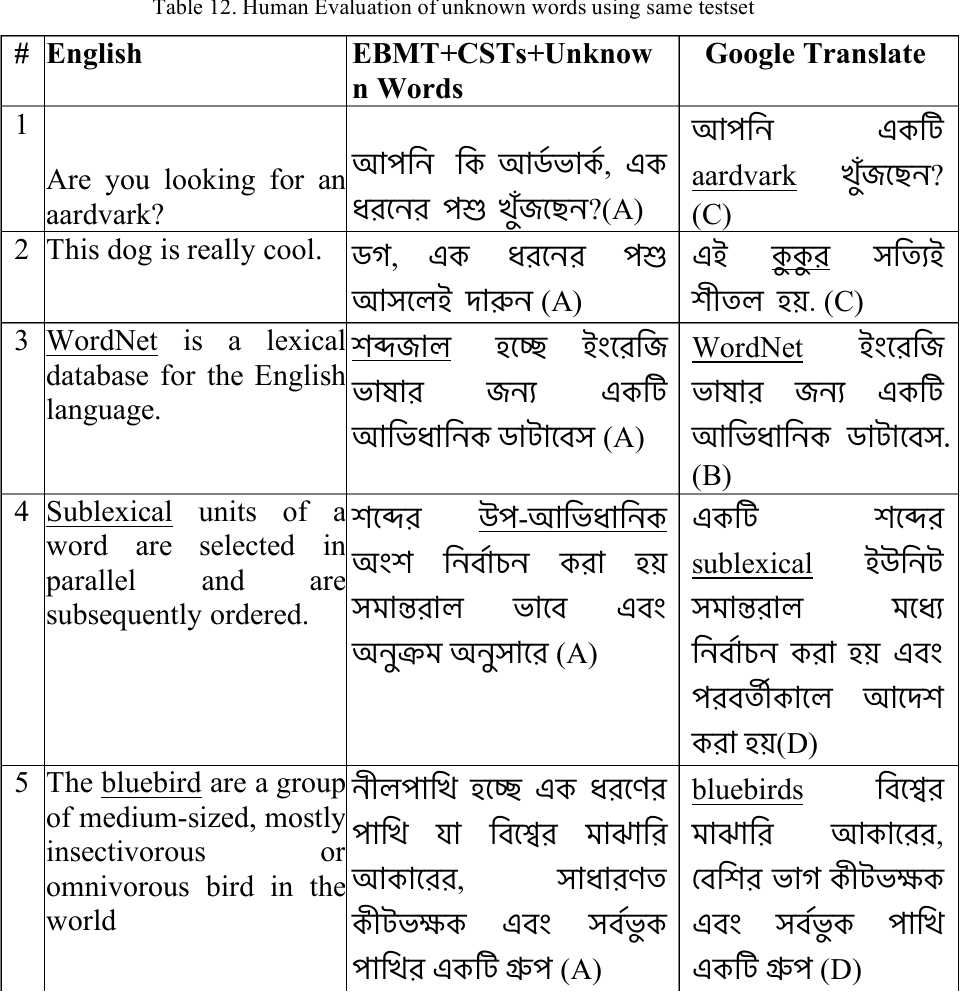
Table 12. Human Evaluation of unknown words using same